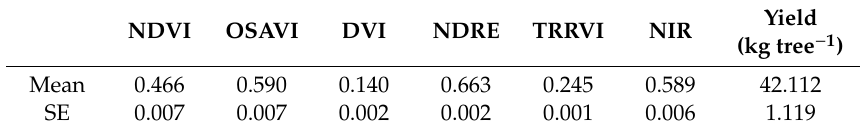
Table 2. Mean values and standard error of yield and remote plant vegetation indices. NDVI OSAVI DVI NDRE TRRVI NIR